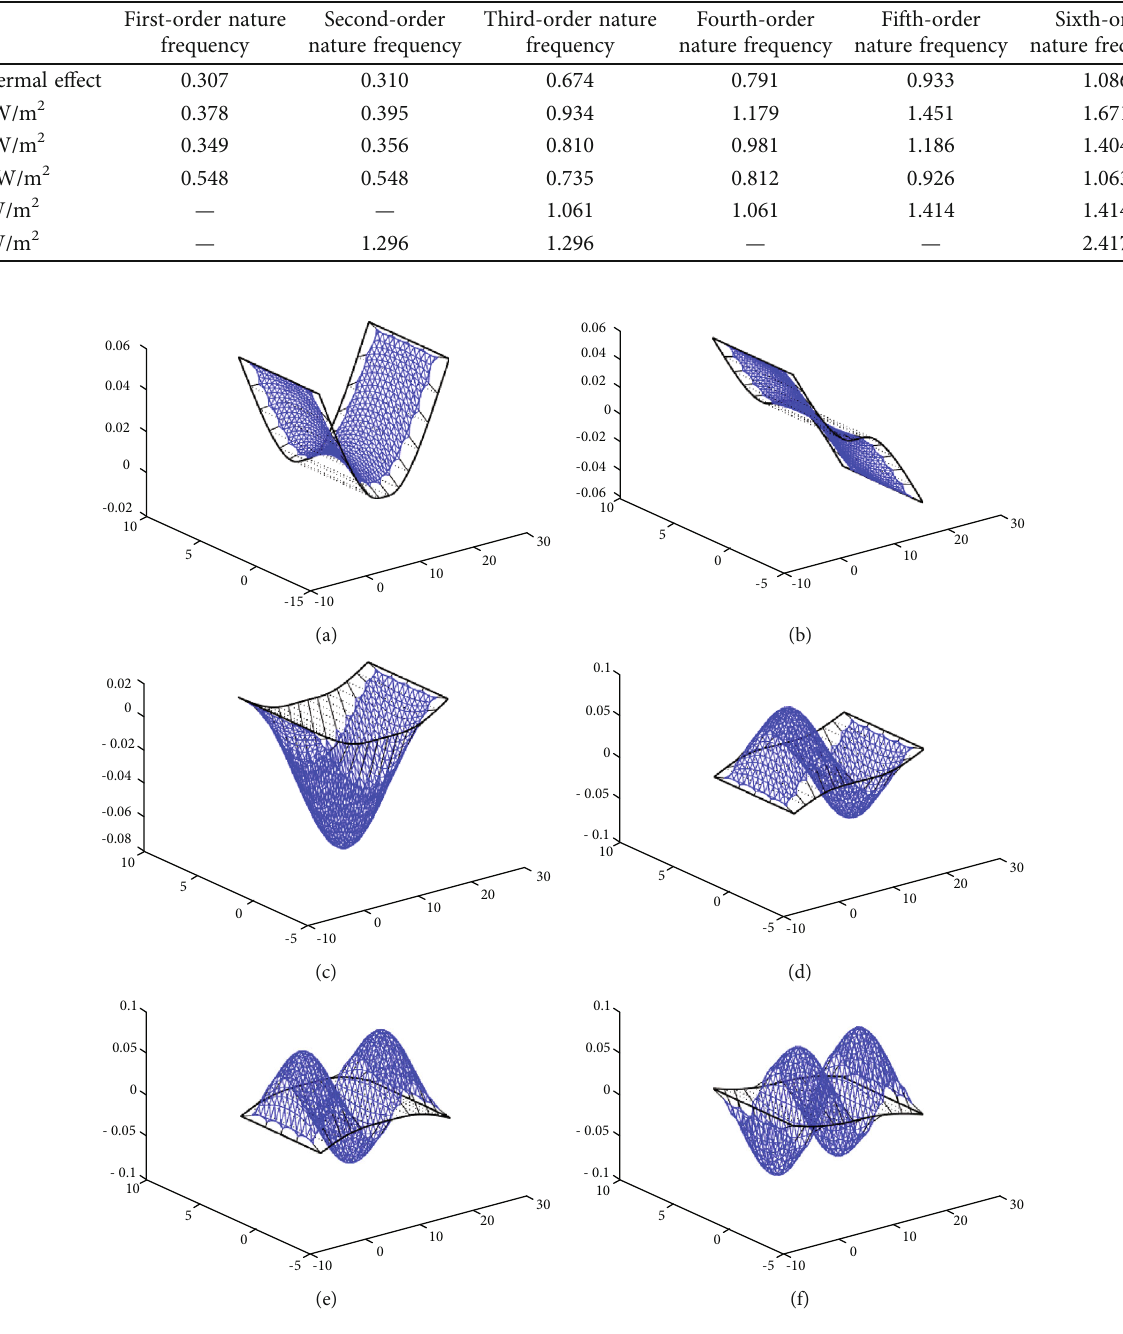
Figure 9: Vibration modes of the membrane antenna structure without considering thermal e ff ects: (a) fi rst mode; (b) second mode; (c) third mode; (d) fourth mode; (e) fi fth mode; (f) sixth mode.